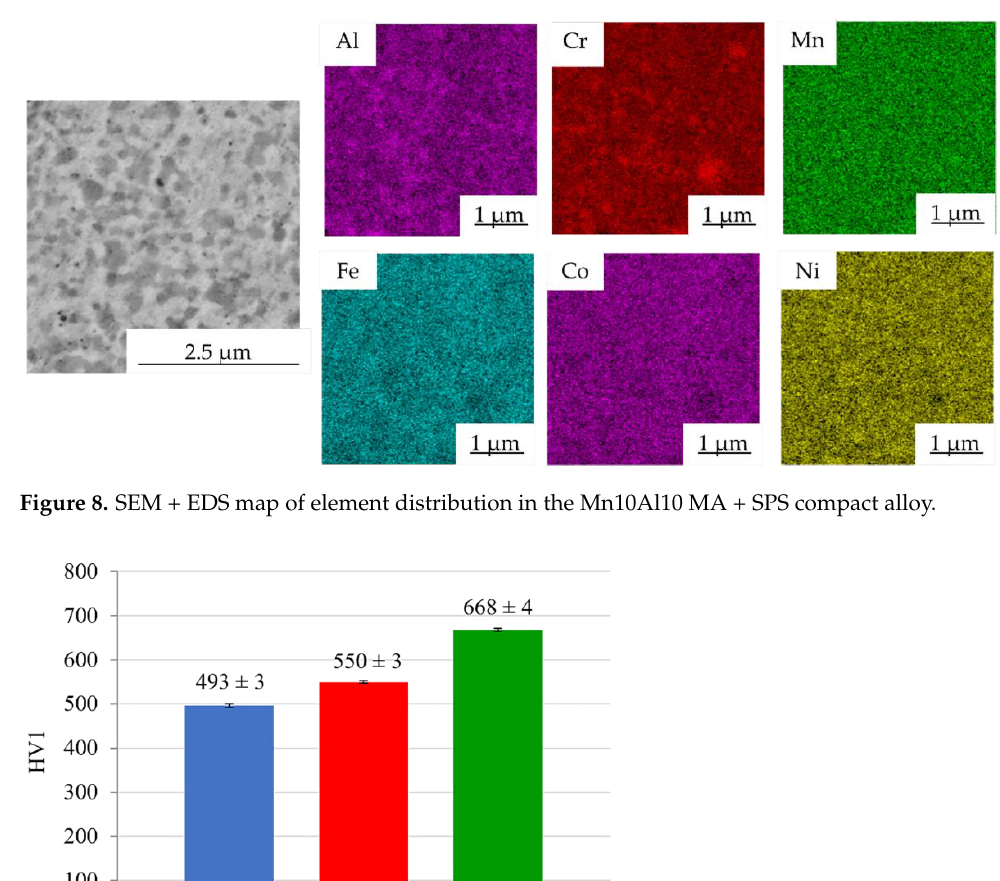
Figure 8. SEM + EDS map of element distribution in the Mn10Al10 MA + SPS compact alloy.